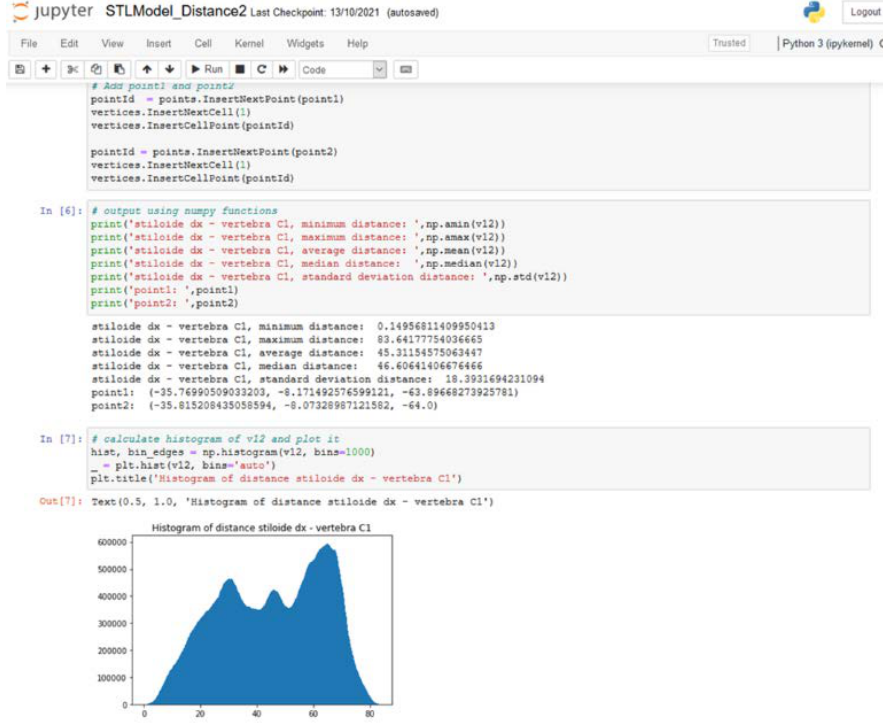
Figure 2. Dedicated software to calculate spatial orientation.